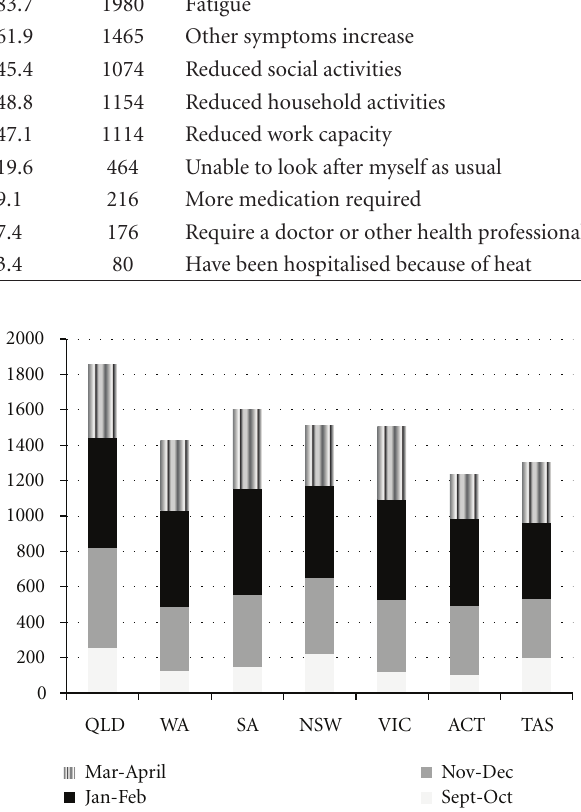
Figure 1: Mean hours of air-conditioner use per household.